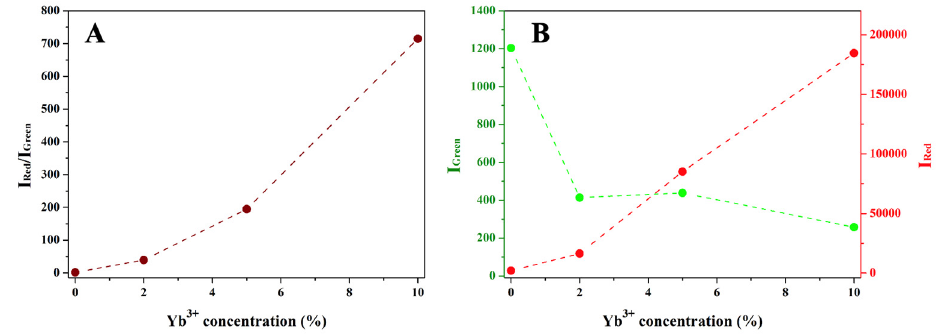
Figure 9. Variation of I Red /I Green value ( A ) and of I Red and I Green intensities ( B ) with the change in Yb 3+ loading; (I Red and I Green represent the integrated intensities of red and green UC emission, respec- tively).